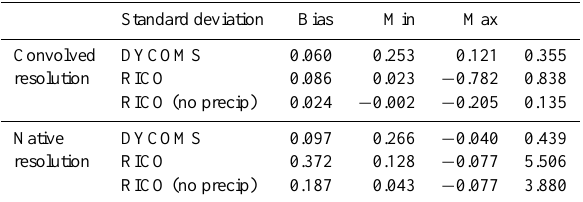
Table 2. Statistics of the error for the retrieval of the total column integrated water vapor assuming a naïve linear regression based re-